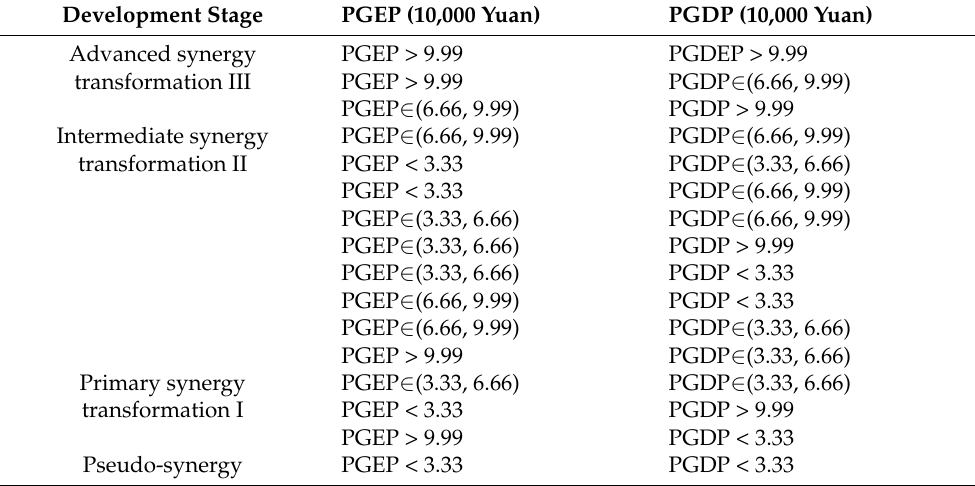
Table 2. Criteria for distinguishing GEP–GDP synergistic